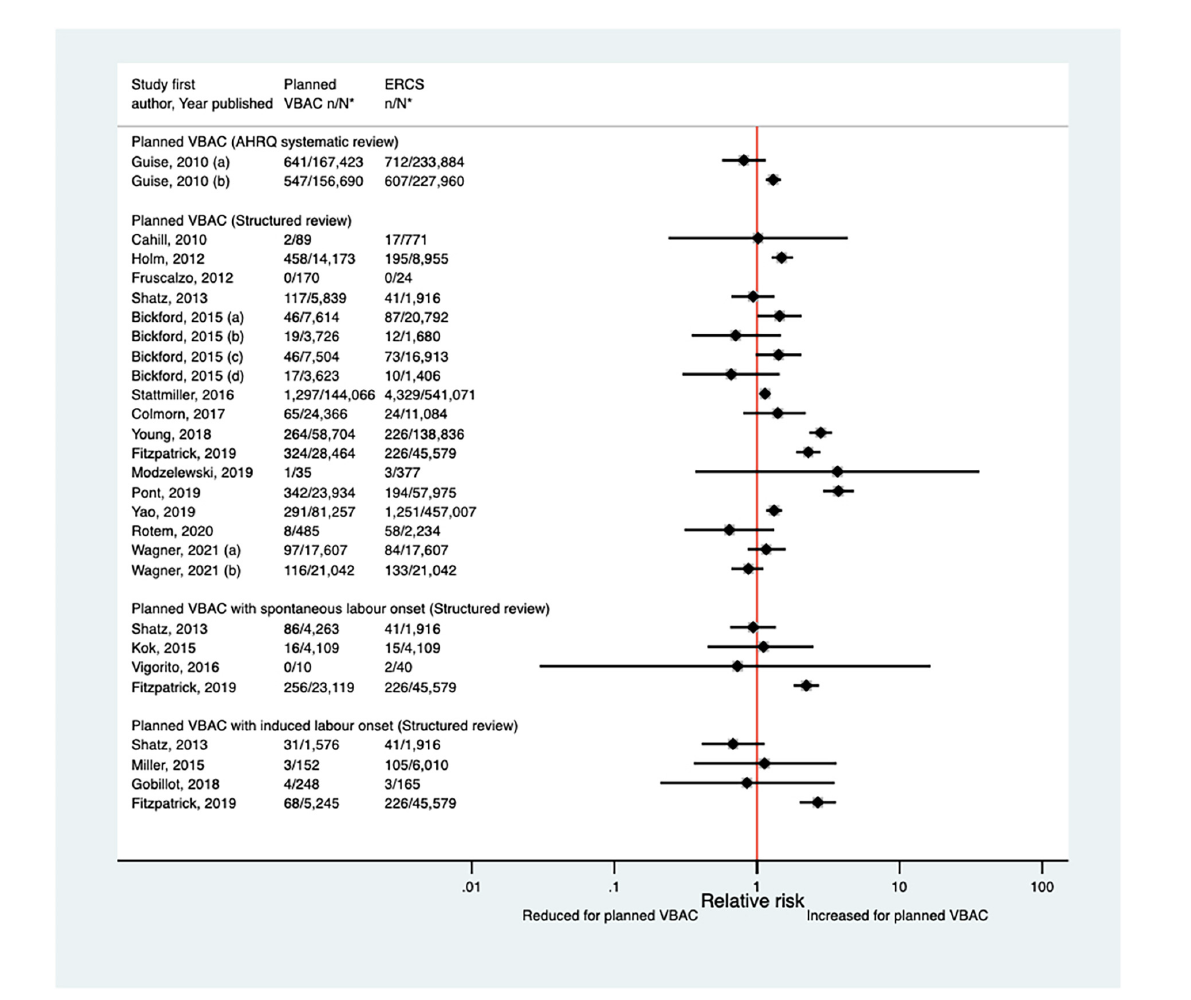
FIGURE4 Risk of blood transfusion for planned VBAC vs. ERCS. ∗ n , number in group with the outcome; N , Total number in group. Guise et al. (20) (a) risk in women who gave birth at any gestational age, (b) risk in women who gave birth at ≥ 37 weeks’ gestation; Bickford and Janssen (50) (a) risk in women with 1–2 prior CSs only, (b) risk in women with 1–2 prior CSs and ≥ 1 prior VB, (c) risk in women with 1 prior CS only, (d) risk in women with 1 prior CS and ≥ 1 prior VB. Wagner et al. (77) (a) Risk in women with no prior vaginal births. (b) Risk in women with ≥ 1 prior vaginal birth. AHRQ, Agency for Healthcare Research and quality; CS, cesarean section; ERCS, elective repeat cesarean section; VBAC, vaginal birth after previous cesarean; VB, vaginal